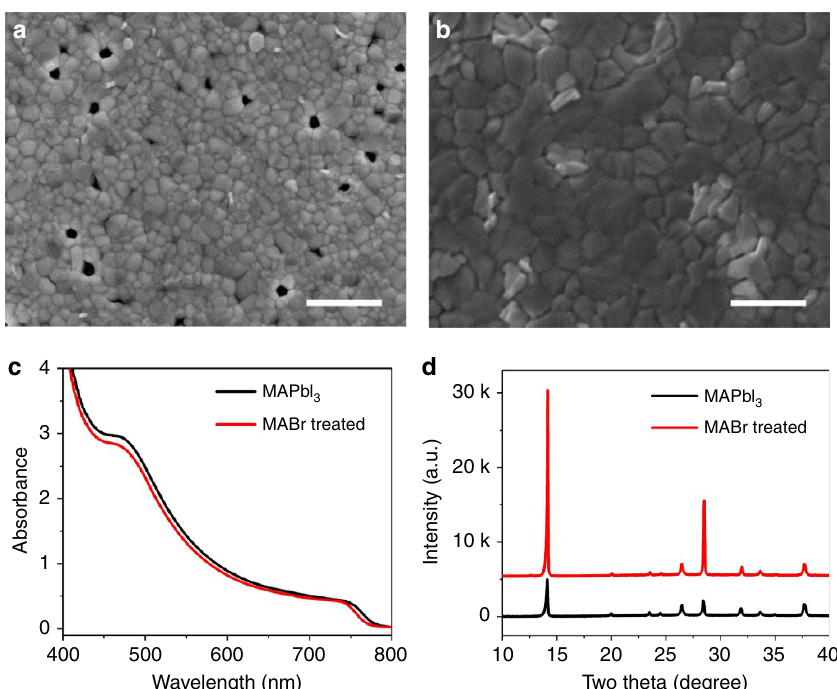
Figure 1 | Impact of MABr treatment on the structural and electro-optical properties of MAPbI 3 thin film. Top view of the SEM images of ( a ) MAPbI 3 and ( b ) MABr-treated MAPbI 3 films. Scale bars, 1 m m. Comparison of ( c ) UV-vis absorption spectra and ( d ) X-ray diffraction patterns of MAPbI 3 films with and without MABr